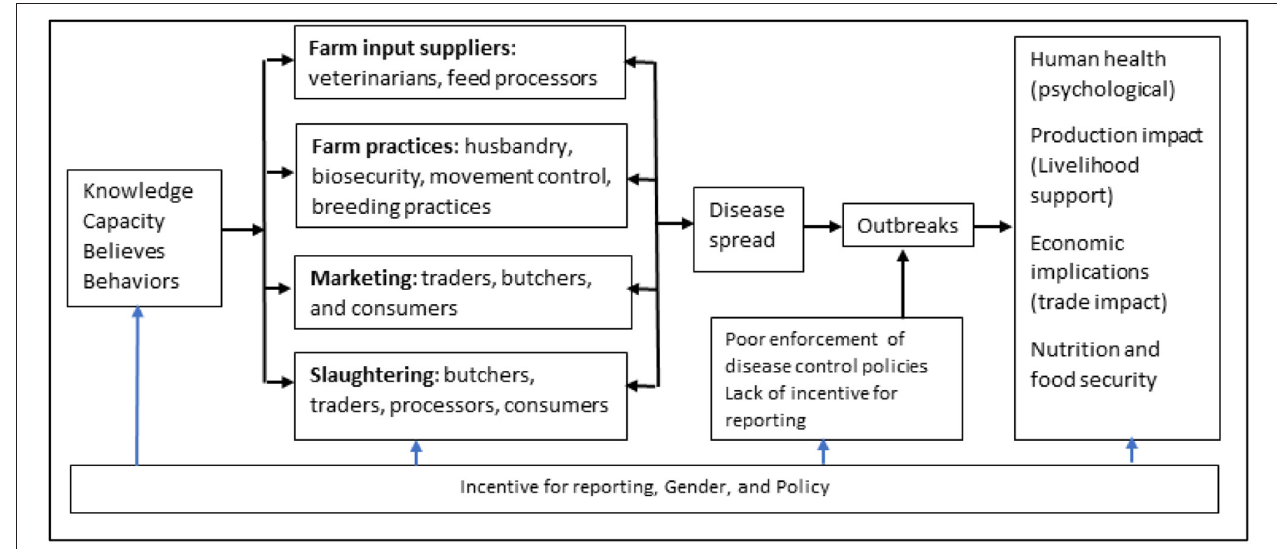
FIGURE 1 | Framework used in the desk-based